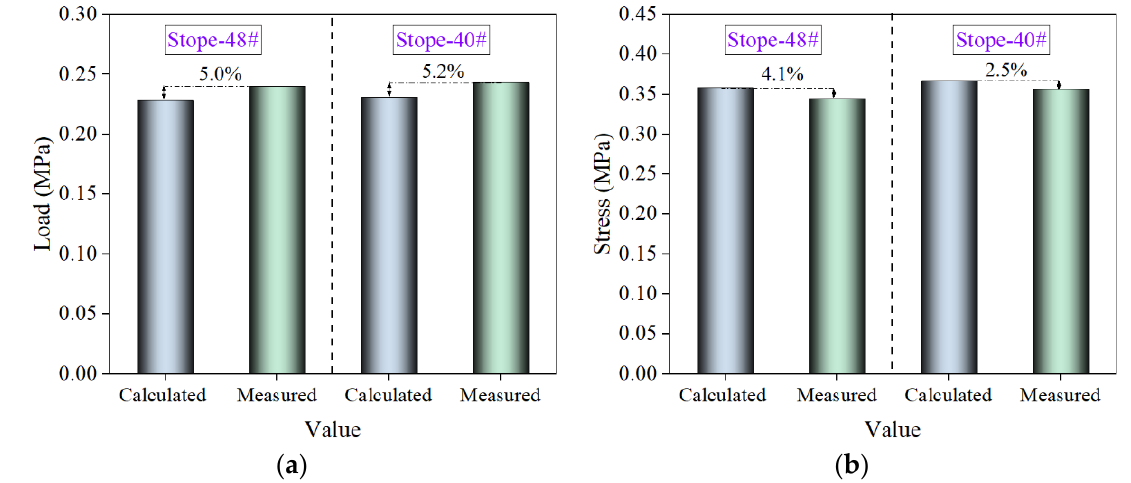
Figure 8. Comparison of calculation and measurement values: ( a ) load, ( b ) stress.